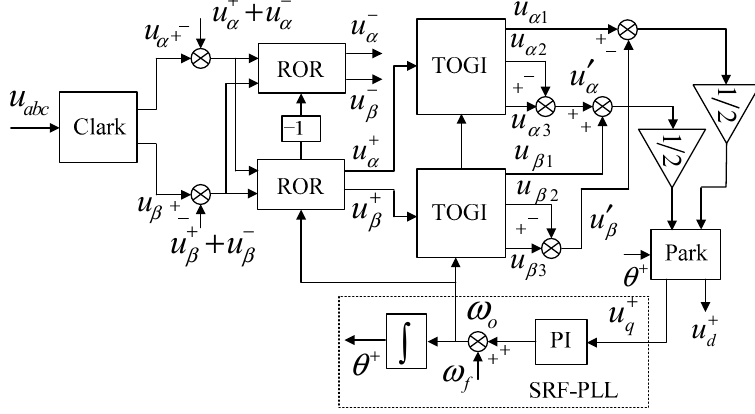
Figure 5. Block diagram of CGI-PLL.